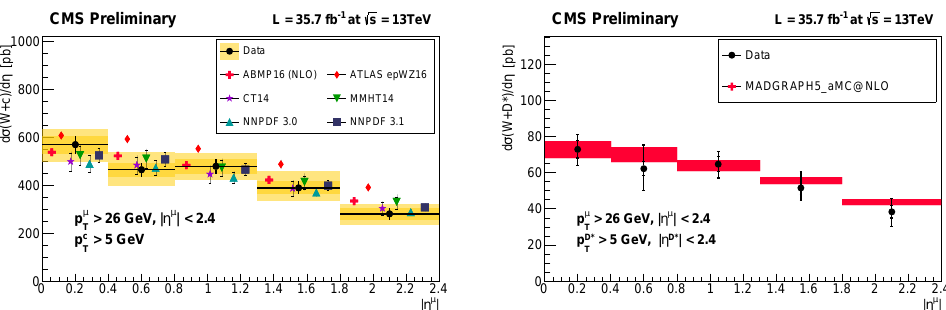
Figure 7. Cross sections of σ (W+c) production at 13 TeV measured as a function of the pseudorapidity of the muon from the W boson decay ( left ), compared to the QCD predictions calculated with MCFM at NLO using different PDF sets. σ (W+D*) production cross sections presented as a function of the pseudorapidity of the muon from the W boson decay ( right ), compared to the predictions of the signal MC accounting for PDF uncertainties and scale variations, which are added in quadrature (shaded band) [25].